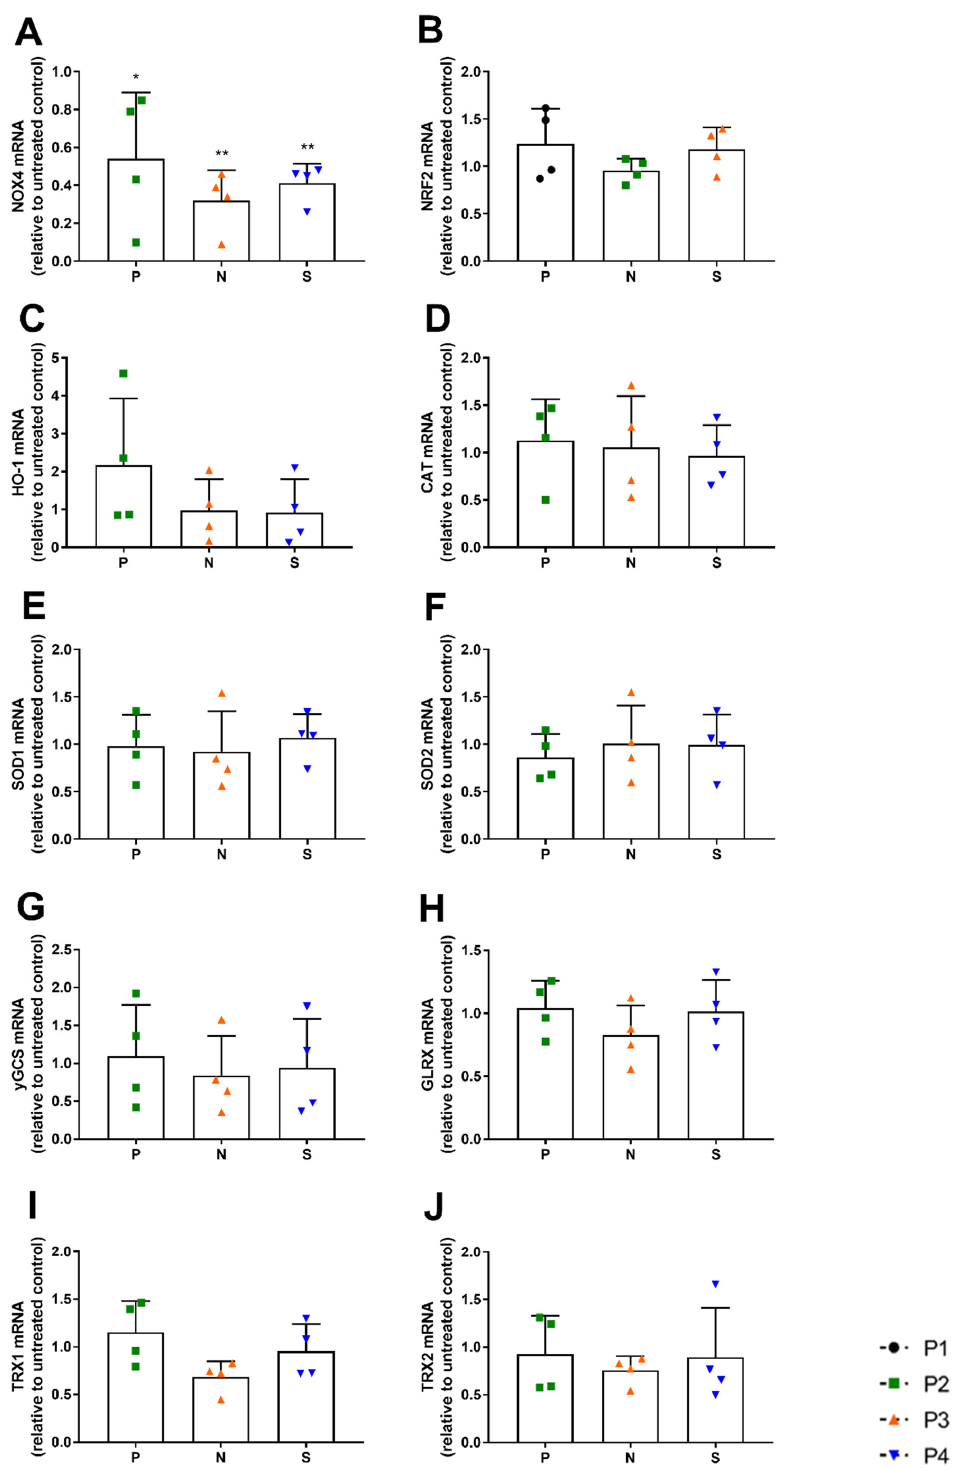
Figure 4. Effect of pirfenidone (P), nintedanib (N) or saracatinib (S) on mRNA expression of NOX4 and antioxidant genes. ( A ) NOX4 expression, ( B ) NRF2 expression, ( C ) HO-1 expression, ( D ) γ GCS expression, ( E ) CAT expression, ( F ) SOD1, ( G ) SOD2 expression, ( H ) GLRX expression, ( I ) TRX1 expression and ( J ) TRX2 expression in HBE cells from IPF patients ( n = 4) after stimulation with pirfenidone (1 mM), nintedanib (0.1 µ M) and saracatinib (1 µ M) for 24 h. The change in gene expression is expressed as a fold increase compared to the untreated control individually per IPF patient (* p < 0.05, ** p <